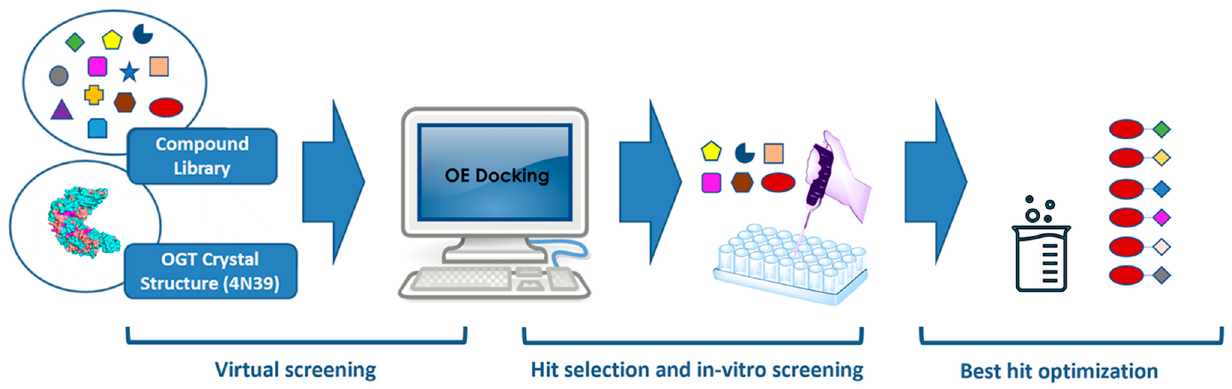
Figure 1. Schematic representation of the virtual screening, hit selection, and hit optimization process used in this study.